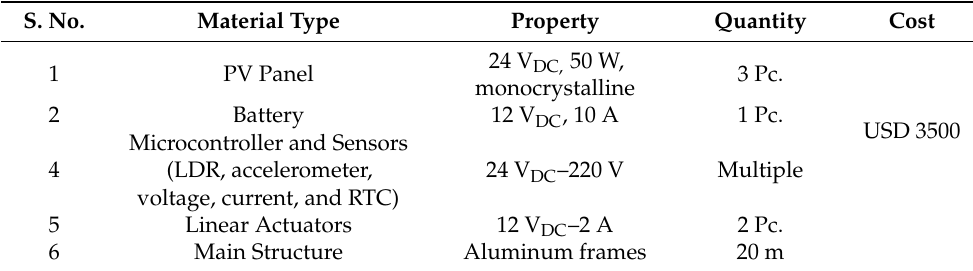
Table 2. Cost of the system.